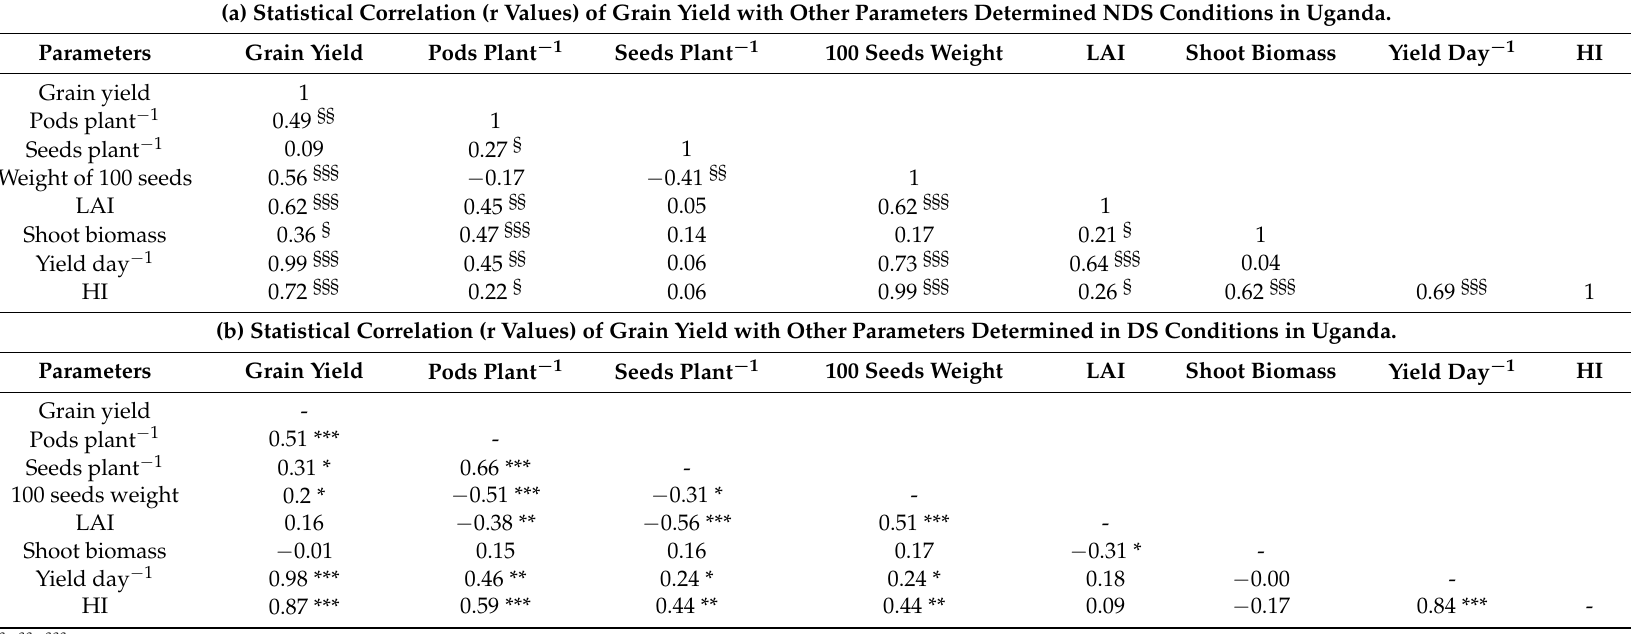
Table 3. Statistical correlation (r values) of grain yield with other parameters determined in DS and NDS conditions in Uganda. (a) Statistical Correlation (r Values) of Grain Yield with Other Parameters Determined NDS Conditions in Uganda.